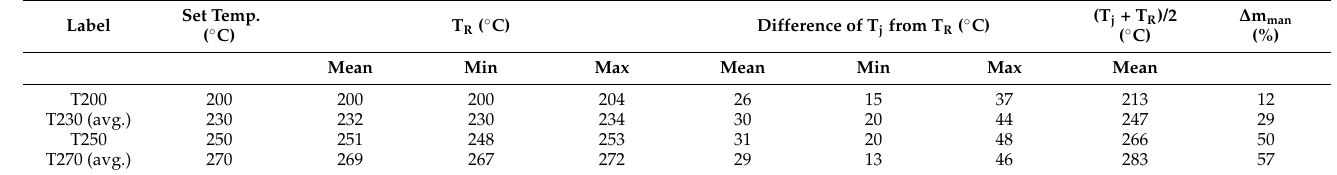
Table 3. Reactor and jacket temperatures of the rotary kiln and the determined mass